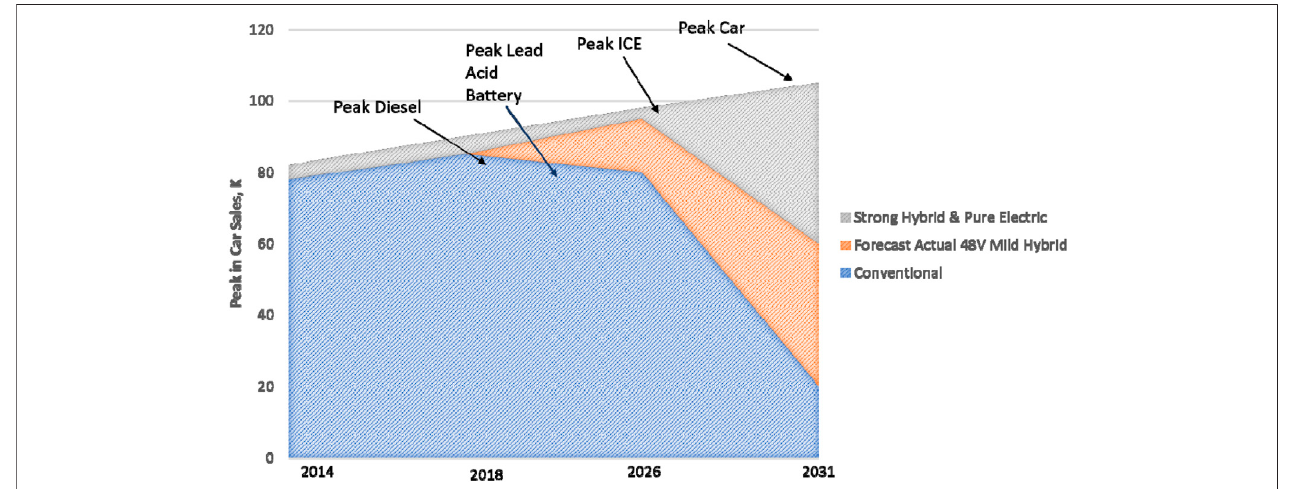
FIGURE 15 | Forecast of global sales of different types of Vehicles. Adapted from (Scrosati and Garche, 2010b).